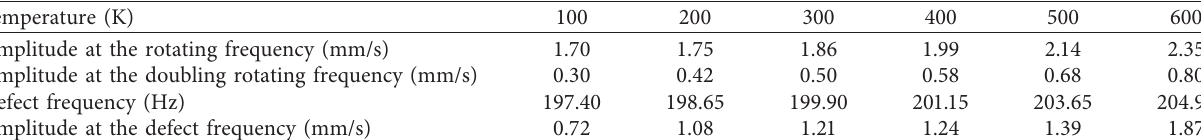
Table 3: Peak frequencies and amplitudes of inner ring vibration in different temperatures.